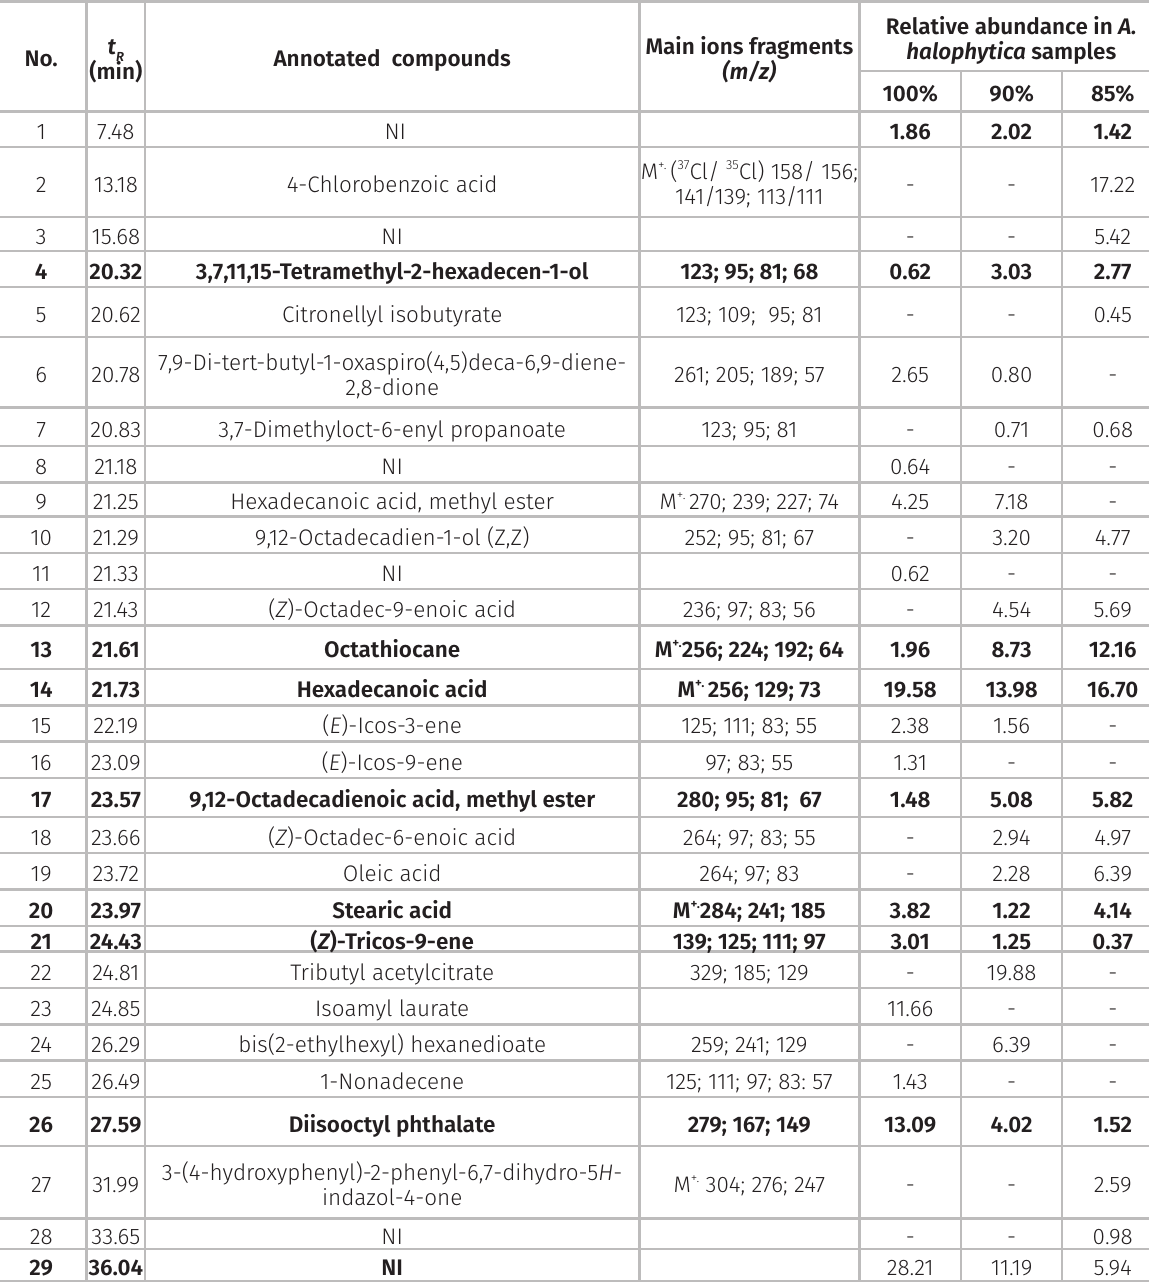
Table II. CG-MS chemical characteristics of secondary metabolites in the cyanobacterial extracts. t No. Annotated compounds R (min)